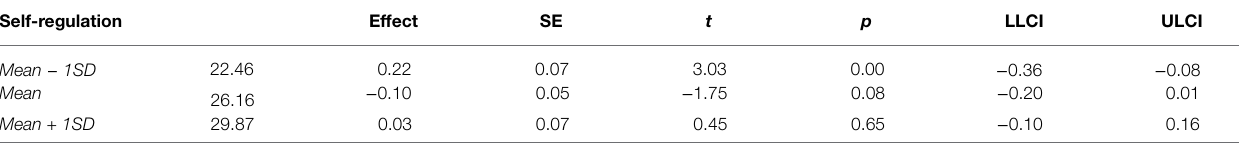
TABLE 4 | Conditional effects of procrastination on life satisfaction at different values of self-regulation in China. Self-regulation